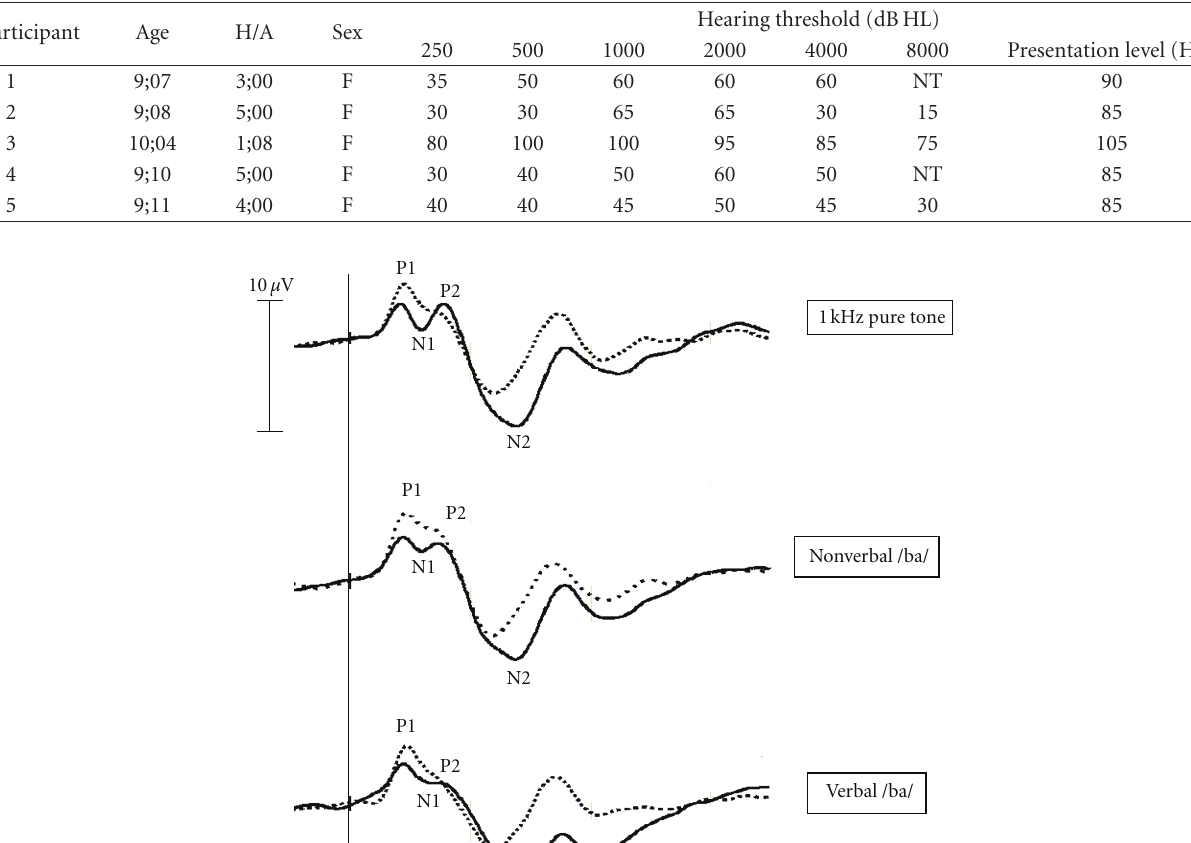
Table 1: Data of nine-to ten-year-old children with hearing loss: age (years; months); age of hearing aids fitting (H/A); sex and hearing loss measured in the right ear at 250 to 8000 Hz (NT: not tested); and stimulus presentation level (dBHL).